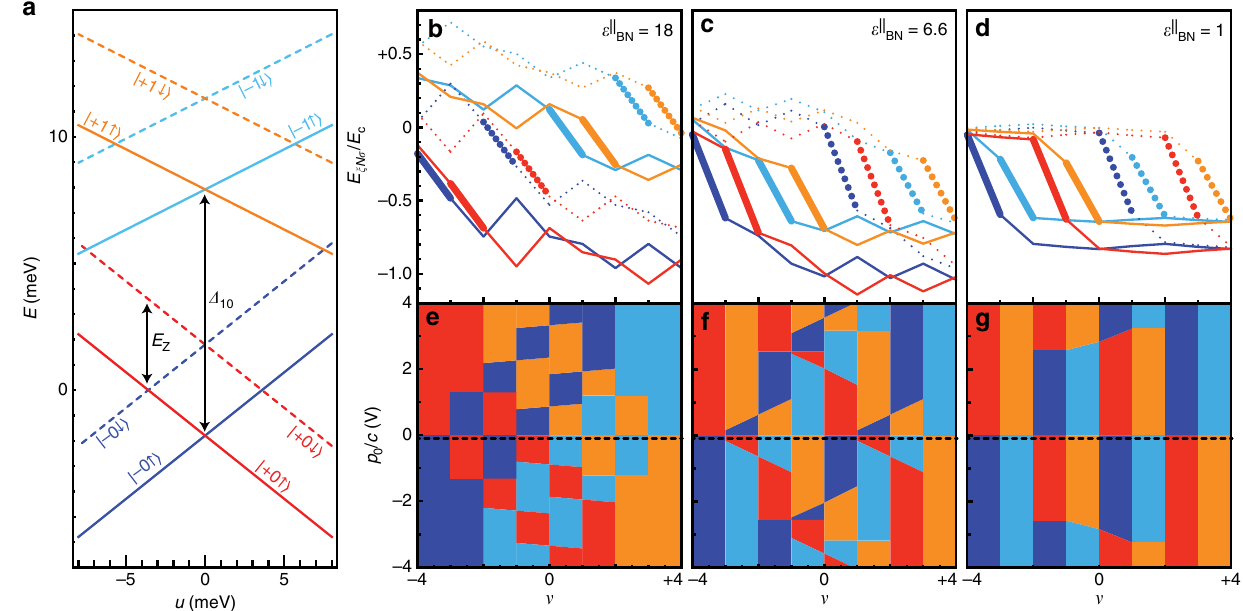
Fig. 3 Theoretical model of spin, valley, and orbital anisotropies in the ZLL. a Single-particle energy spectrum of the ZLL at B = 31 T derived from a four- band tight binding model 29 (see also Eq. (3)). The interlayer potential u couples to the layer polarization of each state as ξα N u , differing in sign for the two valleys and magnitude for the two orbitals; the spin degeneracy is lifted by the Zeeman energy E Z ≈ 3.6 meV; and the N = 0 and 1 orbitals are split by the ¼ (cid:3) 100 mV. Within the Hartree-Fock approximation, we calculate the energy to band structure parameter Δ 10 ≈ 9.7 meV. b – d Level fi lling schematic for p 0 c add an additional electron to level σξ N given the current fi lling { ν σξ N }, generating eight curves ε σξ N ( ν ) which change with the total fi lling ν . Colors indicate the ξ N index of the level, while solid vs. dashed indicates the spin. The bold portion indicates the range of ν over which the level is coincident with the Fermi energy. As isospin σξ fi lls, both of its N = 0 and 1 orbitals decrease in energy due to favorable Coulomb correlations, while the components of the opposite valley (i.e., layer) decrease slightly in energy due to the capacitance of the bilayer. The relative magnitude of these effects, combined with the single- particle splittings, determines the fi lling order, shown here for three interactions strengths parameterized by the boron nitride dielectric constant, ϵ jj . Large BN ϵ jj ¼ 18 ( e ) corresponds to negligible Coulomb interactions, ϵ jj ¼ 6 : 6 ( f ) corresponds to intermediate Coulomb interactions, and ϵ jj ¼ 1 ( g ) BN BN BN corresponds to maximally strong Coulomb interactoins. e – g Hartree-Fock phase diagram in the three interaction strength regimes. Colors blue , cyan , red , and orange indicate whether levels of type ξ N = − 0, − 1, +0, +1 are fi lling, so that the result should mimic the observed C A . The intermediate interaction regime shows good agreement with the experimental C A data, while interactions which are too weak ( e ) or strong ( g ) do not reproduce the observed fi lling sequences. The black dashed line indicates a cut at p 0 / c = − 100 meV corresponding to the particular fi lling sequence shown in b –